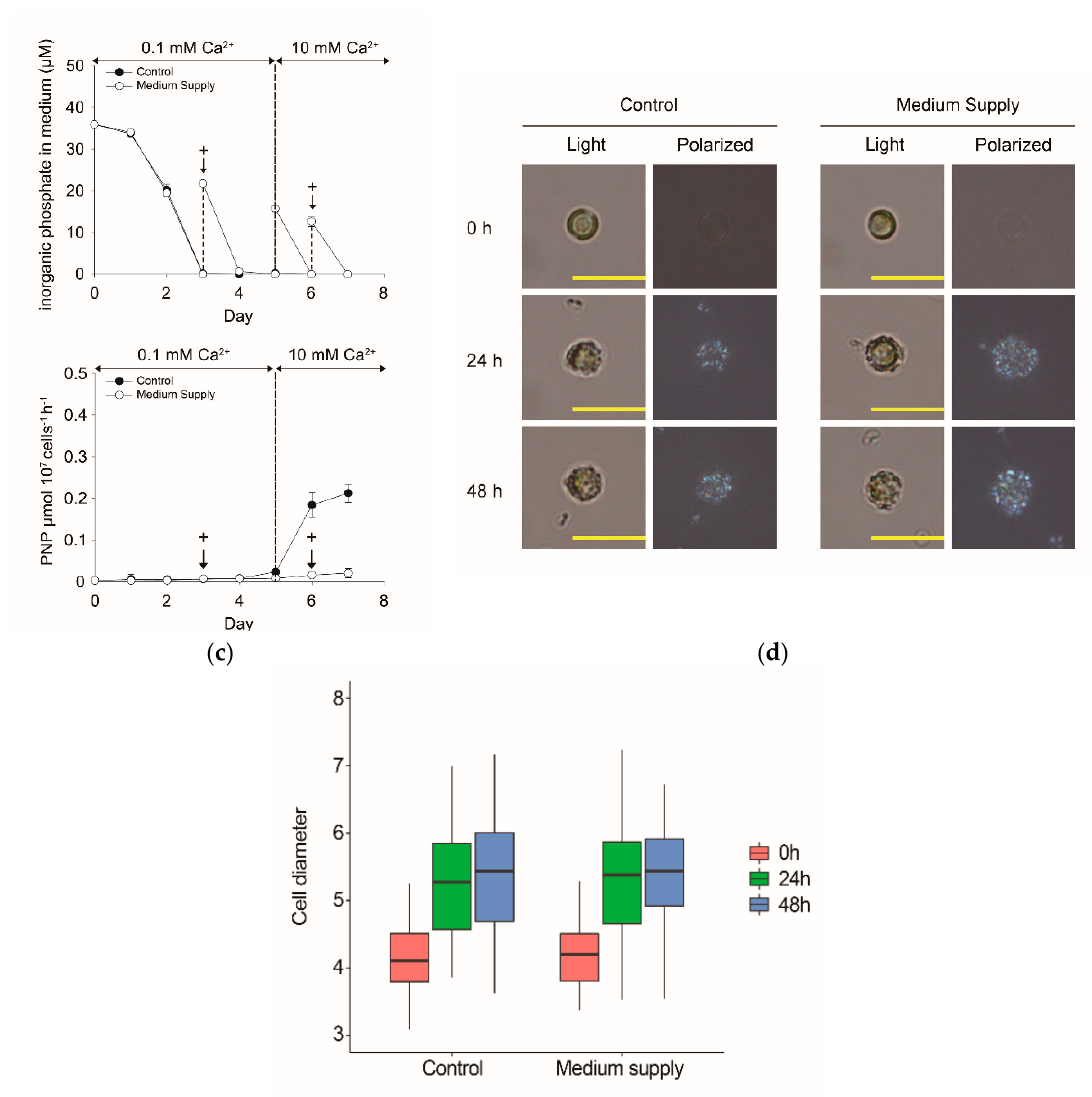
Figure 1. Changes in the physiological and morphological data of coccolith production by the coccolithophore E. huxleyi CCMP 371 when cells grown in low [Ca 2 + ] were suddenly transferred to ambient [Ca 2 + ] conditions under Pi-replete and -limited conditions. ( a ) Experimental design showing the manner in which [Ca 2 + ] and [Pi] were controlled during this experiment. Cells grown in low [Ca 2 + ] (pre-culture) were transferred into the same Ca 2 + -limited (0.1 mM) medium in control and medium supply (MS) conditions on Day 0. On Day 3, the fresh Ca 2 + -limited medium was added to the MS culture (indicated by arrows [with + ]) but not the control. On Day 5, both control and MS cultures were suddenly transferred to 10 mM [Ca 2 + ] conditions. Thereafter, the MS culture was diluted once more with the ambient seawater medium on Day 6; the control was not diluted. ( b ) Change in growth as monitored by cell number. ( c ) Changes in [Pi] in the culture medium and external alkaline phosphatase activity (expressed as PNP) as a parameter of Pi limitation. ( d ) Microscopic observation under light and polarized microscopes for monitoring whole-cell images and coccoliths produced as cell covering, respectively. The cell image presented is one typical example. The yellow bar indicates a 10- µ m scale. ( e ) Cell diameter measured and shown as boxplots. More than 60 individual cells were examined, and the box color indicates the time point after shifting [Ca 2 + ] from 0.1 to 10 mM (red: 0 h, green: 24 h, blue: 48 h, cell diameter: μ m).